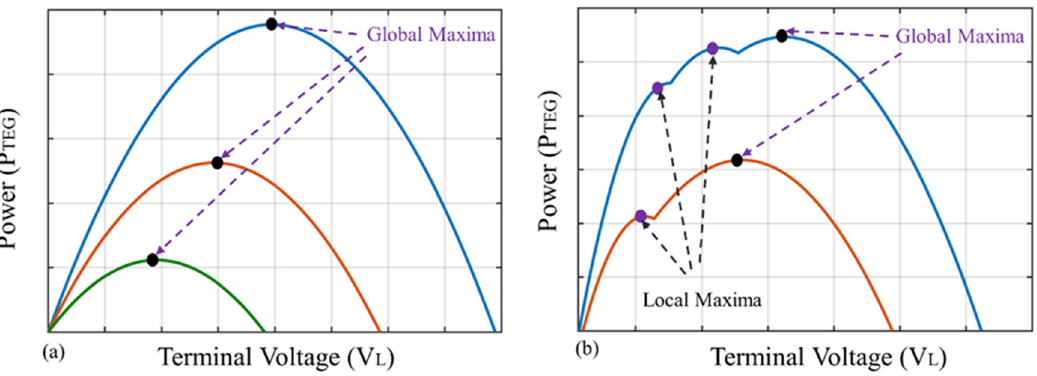
Figure 4. P ‒ V curve of TEG modules under ( a ) uniform temperature and ( b ) non-uniform tempera- Figure 4. P–V curve of TEG modules under ( a ) uniform temperature and ( b ) non-uniform ture.